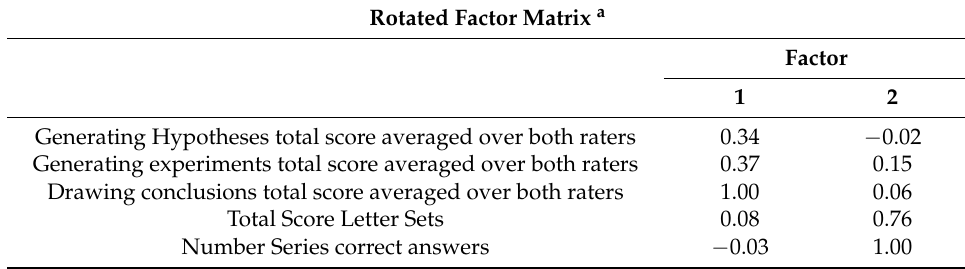
Table 4. Rotated maximum likelihood common factor matrix in the Study 1 factor analysis of the total scores of our subscales and the analytical ability